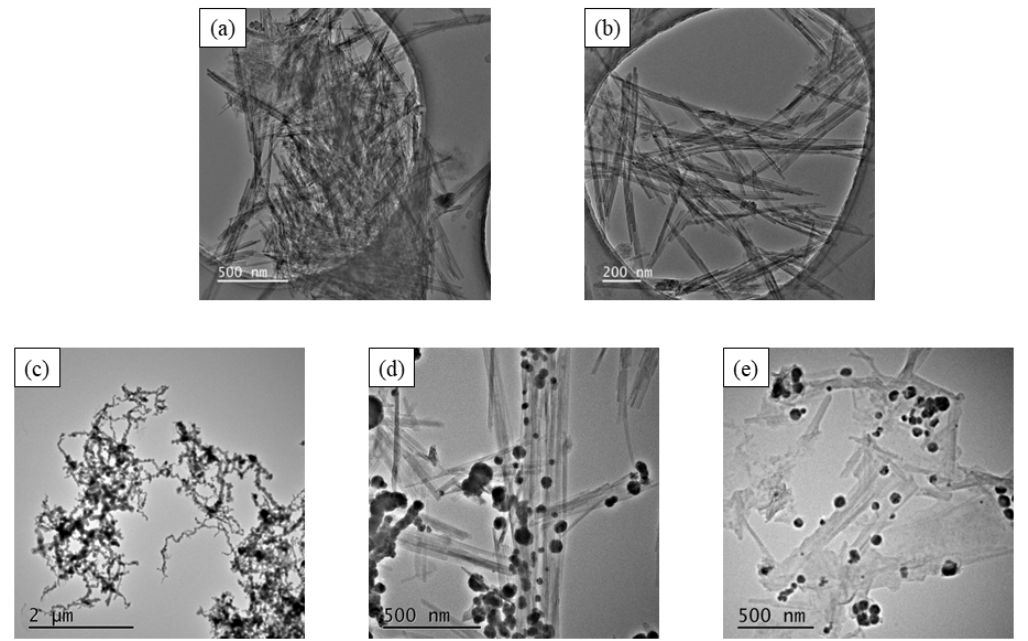
Figure 1. TEM images of ( a ) ATP, ( b ) D-ATP, ( c ) nFe/Ni, ( d ) ATP-nFe/Ni and ( e )